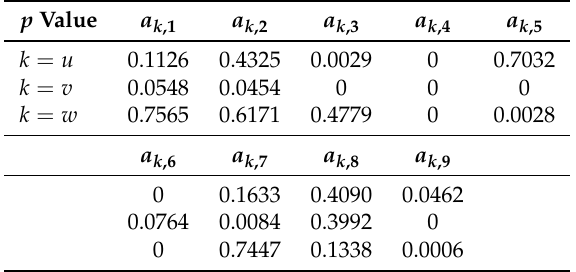
Table 6. Importance of variables in F k regression.